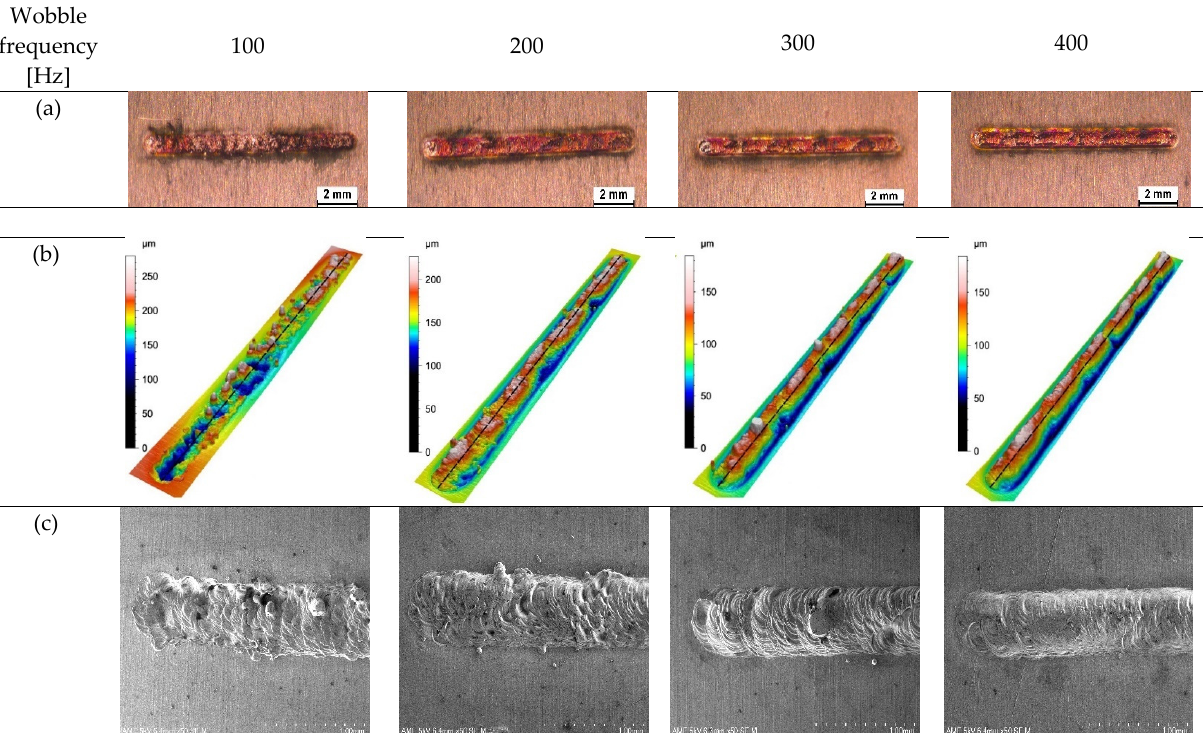
Figure 7. Top view of samples produced with different wobbling frequencies (100 Hz, 200 Hz, 300 Hz, and 400 Hz) using ( a ) optical microscopy, ( b ) 3D surface plotting, and ( c ) scanning electron microscopy (P = 750 W, PRR = 20 Hz, PW = 10 ms, A = 0.4 mm, V w = 2 mm/s, and gas flow = 15